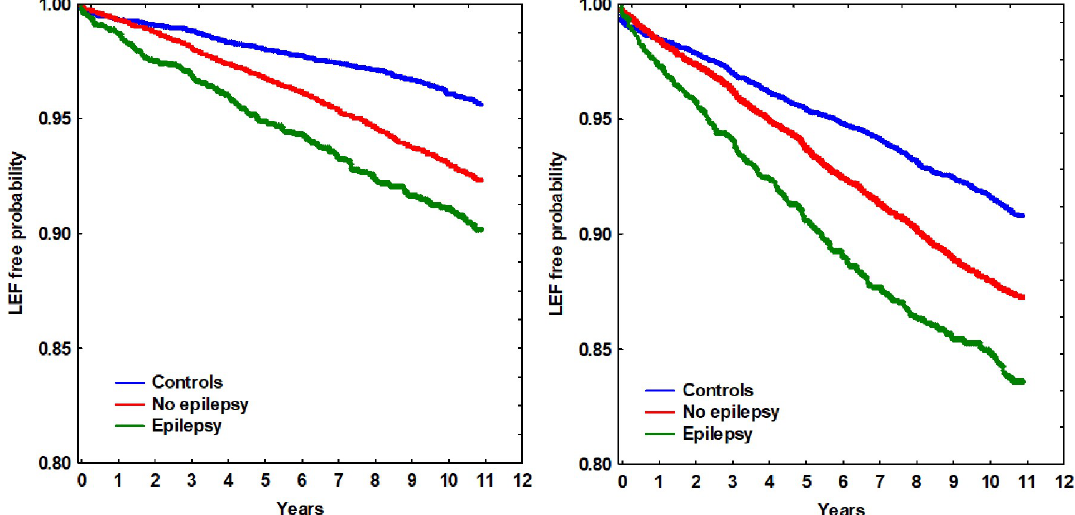
Fig 3. Low energy fracture-free probability over time in relation to being prescribed antiepileptic drugs and having a registered epilepsy diagnosis or not, compared to controls for men (left) and women (right), respectively.